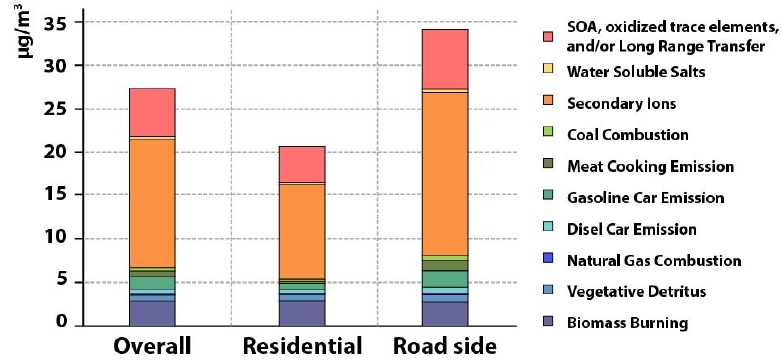
Figure 5. Source apportionment results of PM 2.5 .